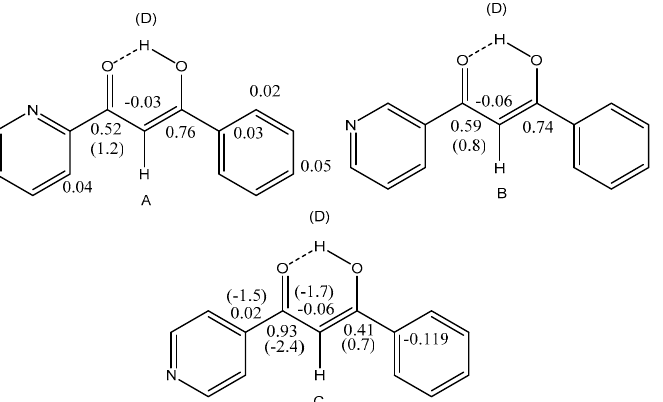
Figure 21. Deuterium isotope effects on 13 C chemical shifts in the liquid and solid state. Only one tautomer is shown (see Figure 15). Numbers in brackets are from the solid state. Deuteration may also take place at C-2. Those isotope effects are small and do not tell us about the equilibrium and are left out for clarity. See Ref. [51].